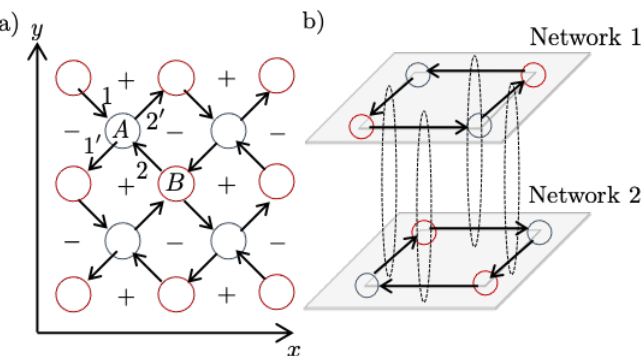
π that are rotated by . The links carry B 2